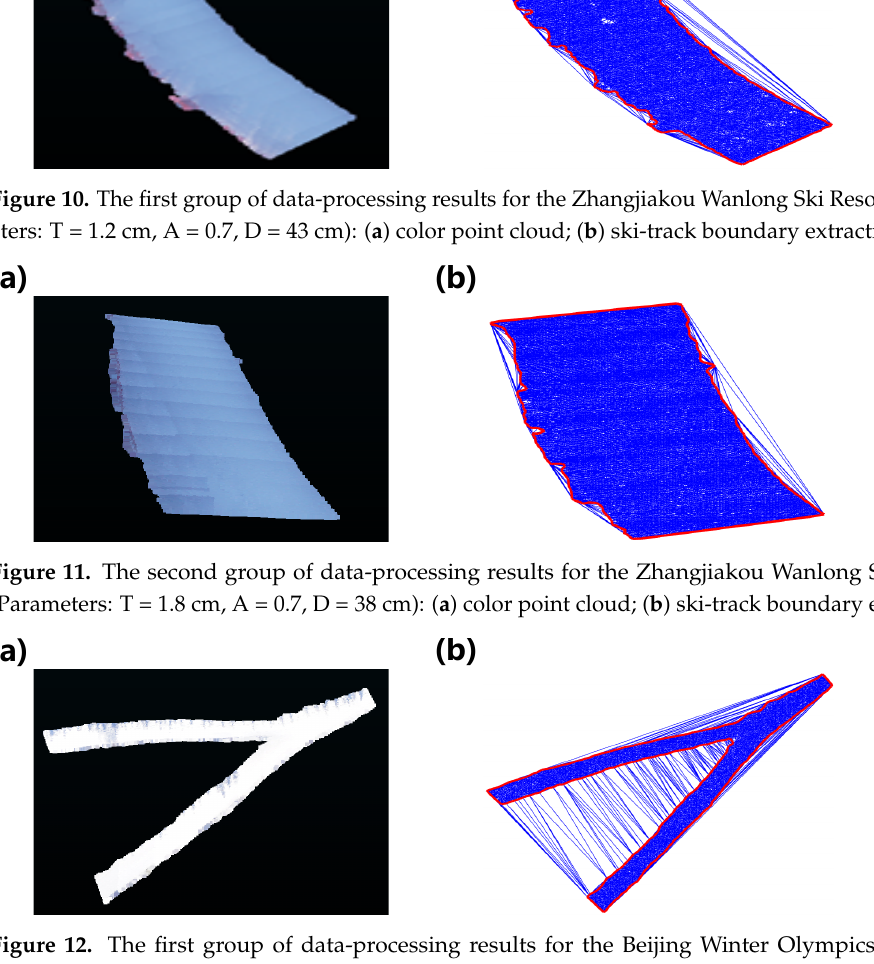
Figure 12. The first group of data-processing results for the Beijing Winter Olympics National Cross-country Skiing Center (Parameters: T = 1.2 cm, A = 0.8, D = 41 cm): ( a ) color point cloud; ( b ) ski-track